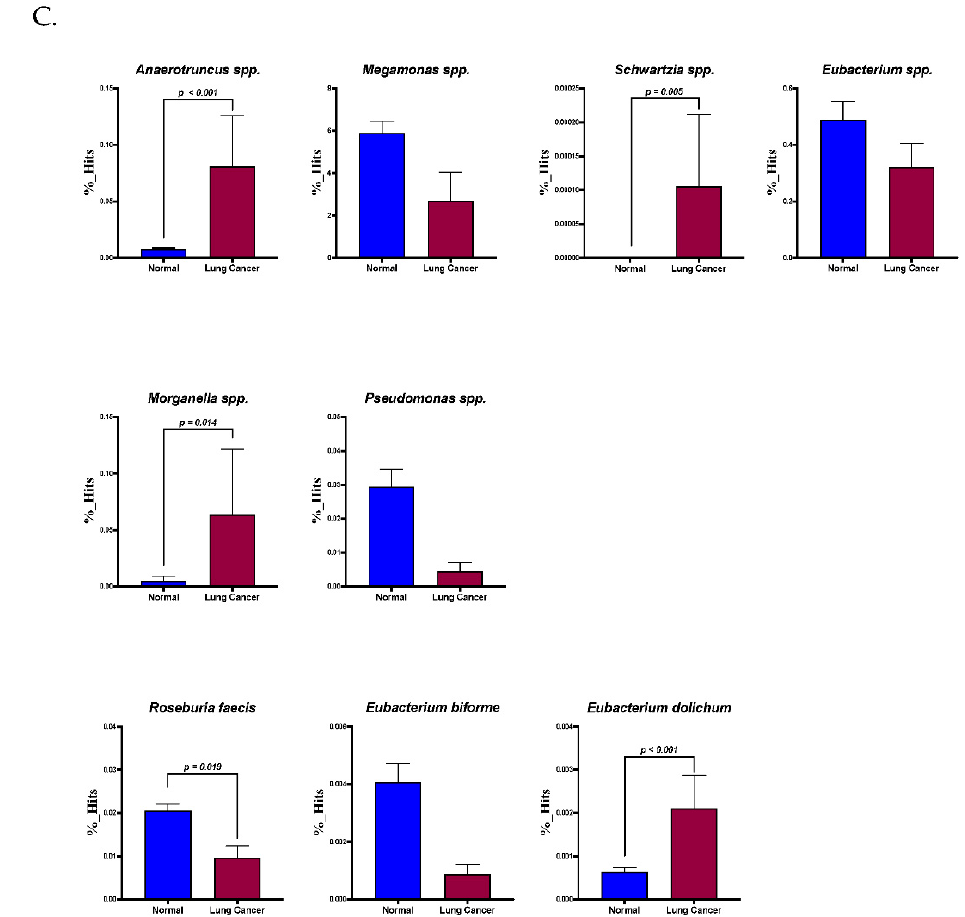
Figure 3. Cladogram and LEfSe plots ( A ) of the core gut microbes are separately illustrated. Bar plots based on the genus and species levels of the core microbes determined from LEfSe analysis are shown in ( B , C ), respectively.